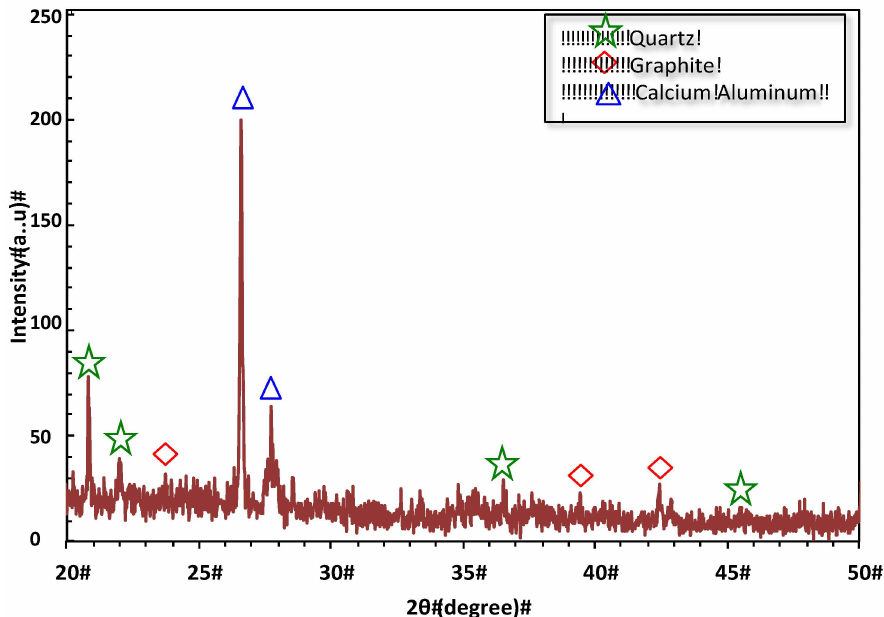
Figure 2. The XRD pattern of the alum sludge granulated bed in constructed wetland systems.